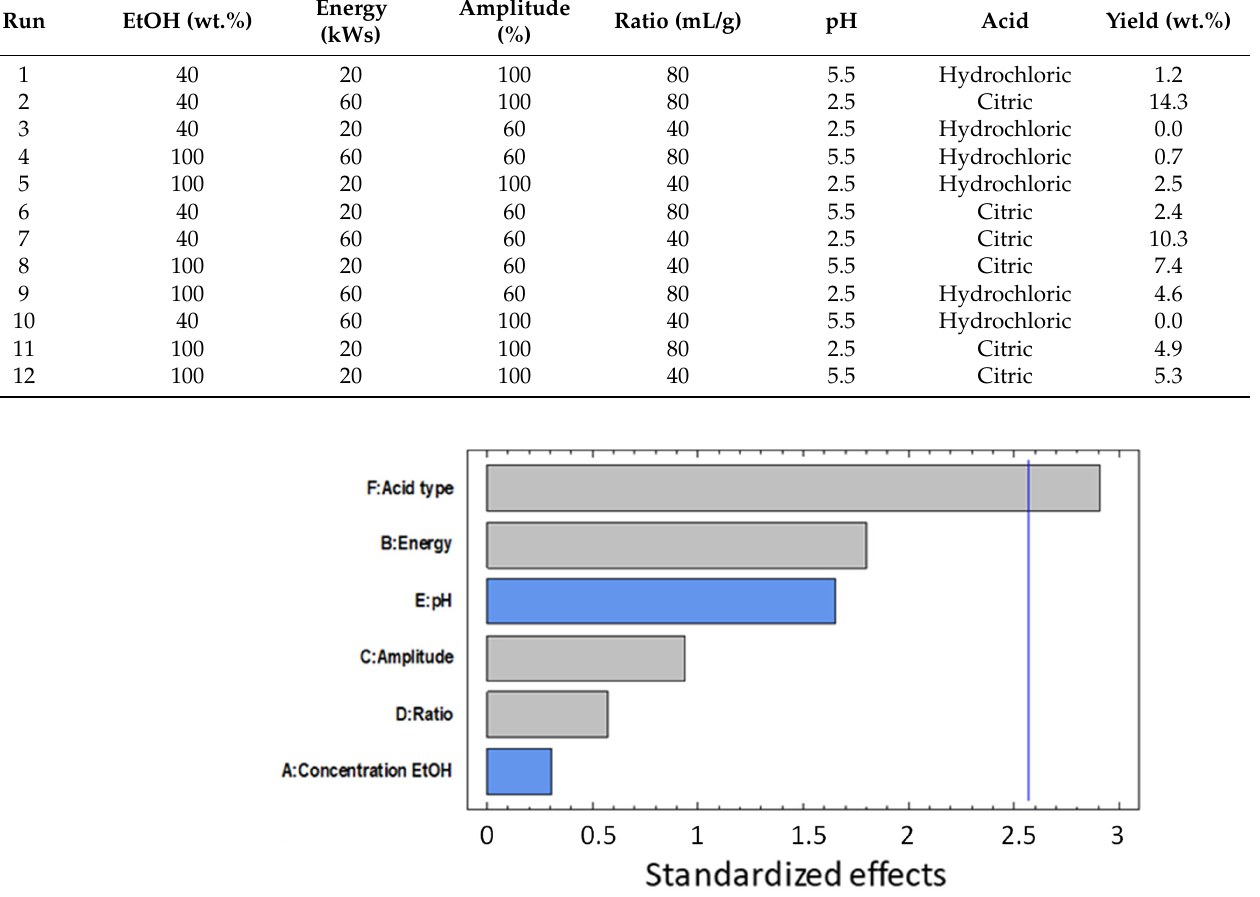
Figure 2. Pareto diagram of standardized effects in UAE for TP to obtain cutin. Table 3. UAE results obtained for Plackett–Burman (III) screening design in TP.